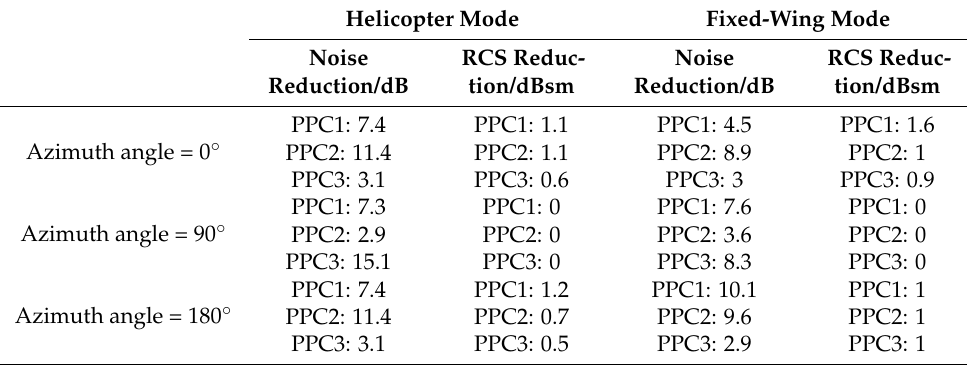
Table 23. Reduction values of noise SPL and average RCS of PPC1, PPC2 and PPC3. Helicopter